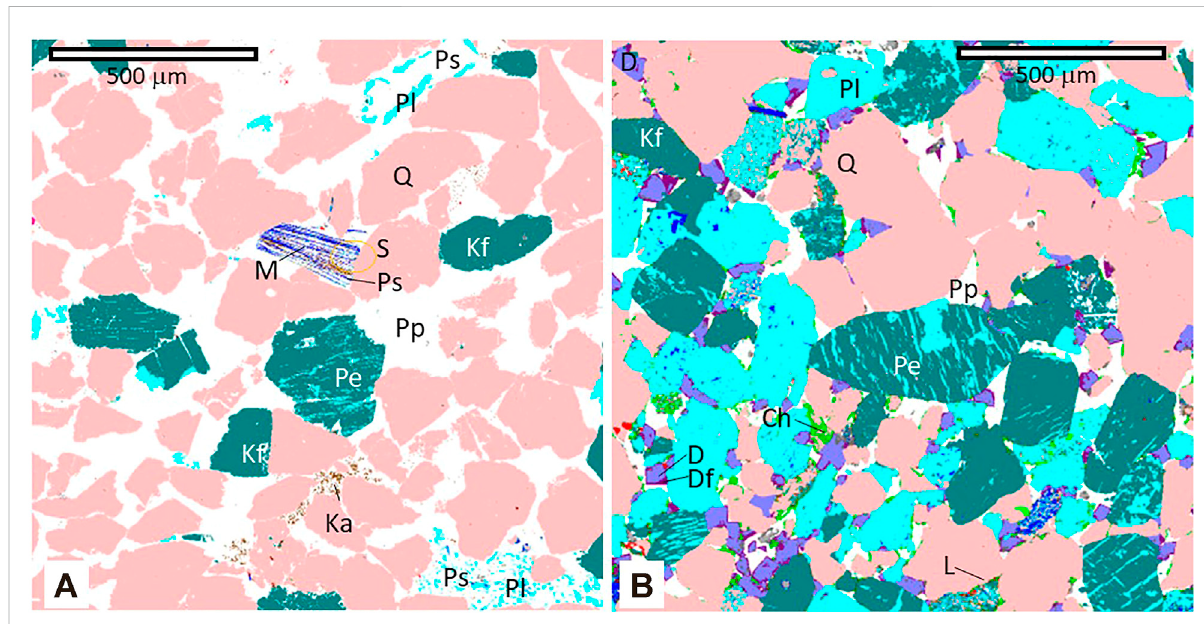
FIGURE 4 Feldspar fabrics in sandstones (mineral colour index in Figure 3). (A) Mid Jurassic mid shoreface sandstone from the North Viking Graben in the NorthSeaBasin withheavily altered (dissolved) plagioclase(Pl),K-feldspar(Kf)and perthite(Pe)grainsundergoingalterationtoillite aswell as detrital quartz (Q). Dissolution of the plagioclase has led to secondary porosity (Ps). This sandstone has elevated primary porosity (Pp) (25%) as it seems to contain little cement apart from patches of kaolinite (Ka) despite being buried to 2,800 m (85 ° C). This rock also contains a muscovite grain (M) that has partly delaminated and developed secondary porosity (Ps) partly fi lled with siderite (S – in orange lozenge) which is close to the limit of resolution of measurement using SEM-EDS: 1 μ m. (B) Detrital quartz, K-feldspar, plagioclase- and perthite (Pe) bearing, Lower Triassic continental red-bed sandstone from the Slyne Basin, Ireland, with minor lithic grains (L) and patchy growth of dolomite cement (D) with later ferroan dolomite rims (Df) leaving about 10% primary porosity. This sandstone has been buried to about 4,200 m (130 ° C) before some uplift (Schmid et al., 2004) and contains 3 to 8 percent each of quartz, K-feldspar and albite cements, that are indistinguishable from detrital host grains using SEM-EDS